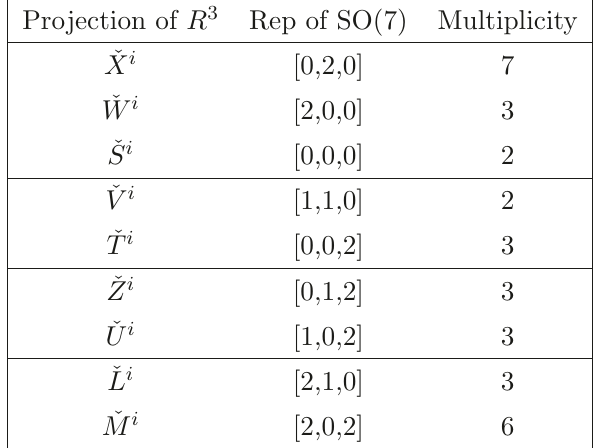
Table 6 . Valid embeddings of